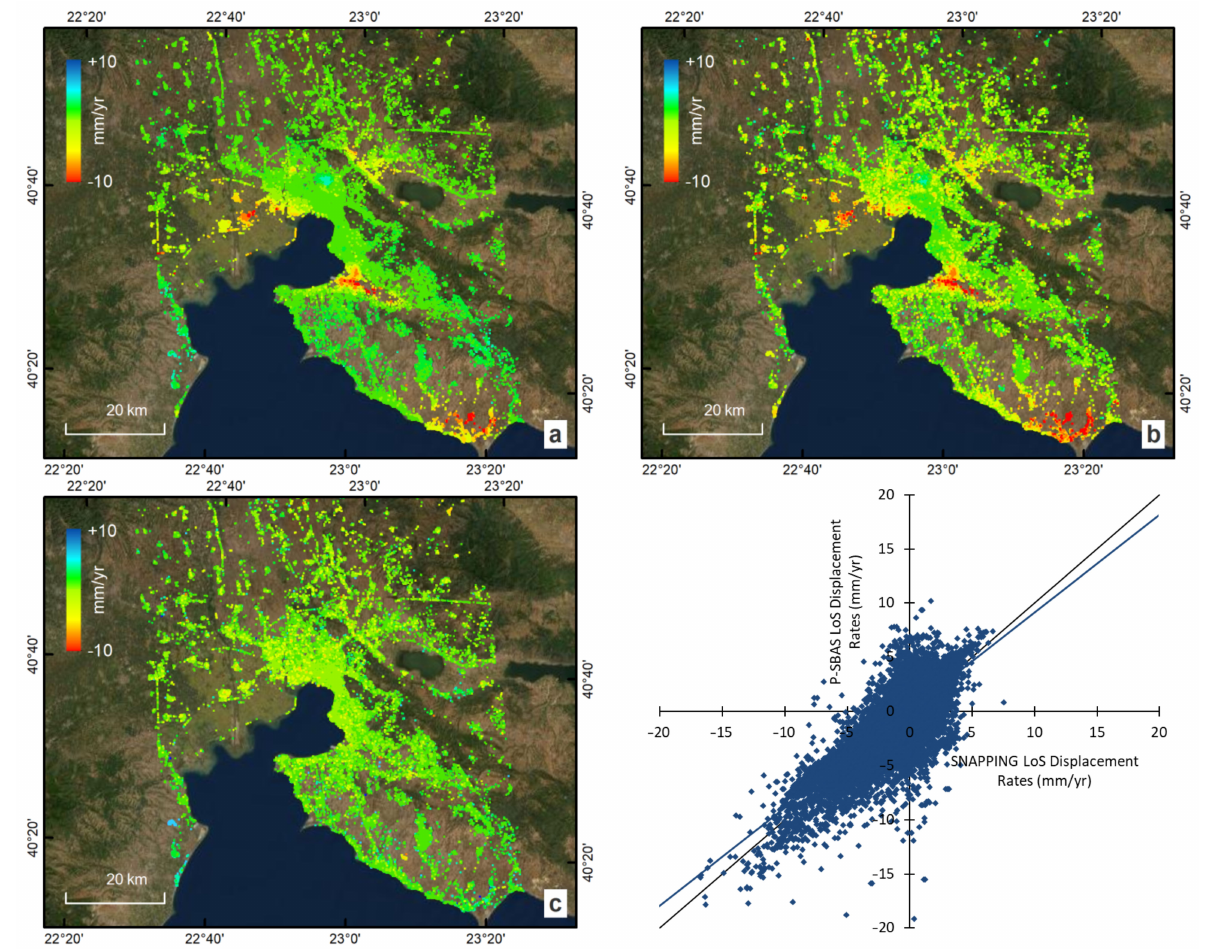
Figure 8. Sentinel-1 LoS displacement rates over the broader Thessaloniki area (Greece) for the period 2015–2020 based on ( a ) SNAPPING and ( b ) P-SBAS services. Differences between the solutions (SNAPPING minus P-SBAS) are spatially shown ( c ), and the dispersion of the calculated motion rates is also plotted. Note that only neighboring points (100 m radius) between the independent solutions are considered. Symbol priority for the visualization (overlap of neighboring points), is given to those with higher subsidence rates. Contains modified Copernicus Sentinel-1 mission data (2015–2020), processed by AUTh on GEP.